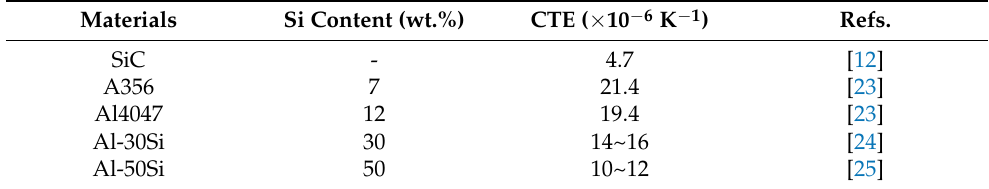
Table 2. CTE values of the